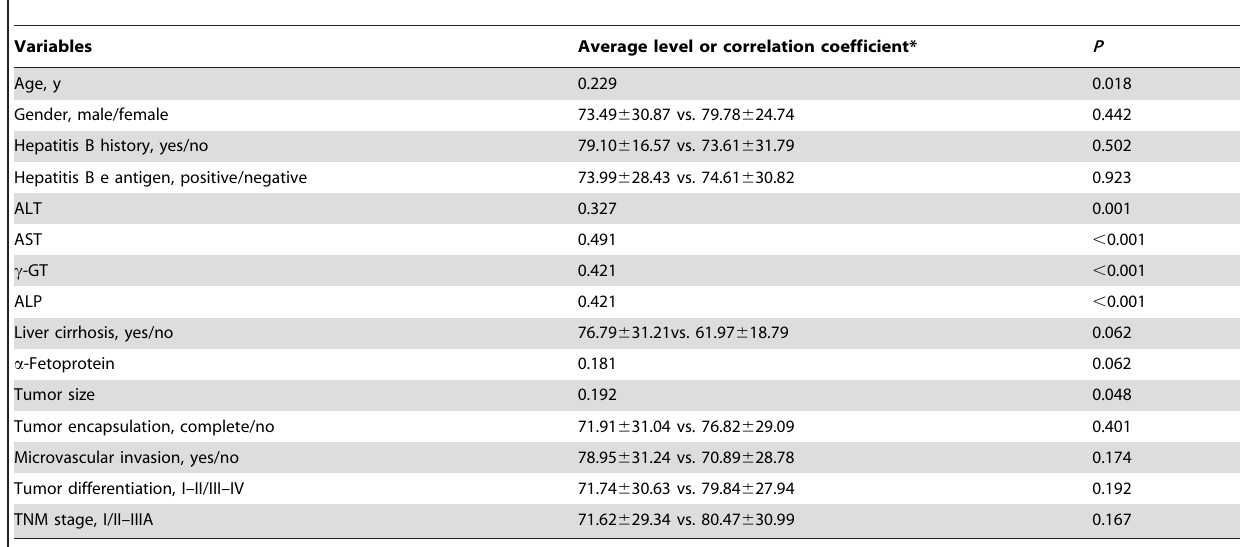
Table 5. Relationships between plasma sCD163 and clinicopathologic